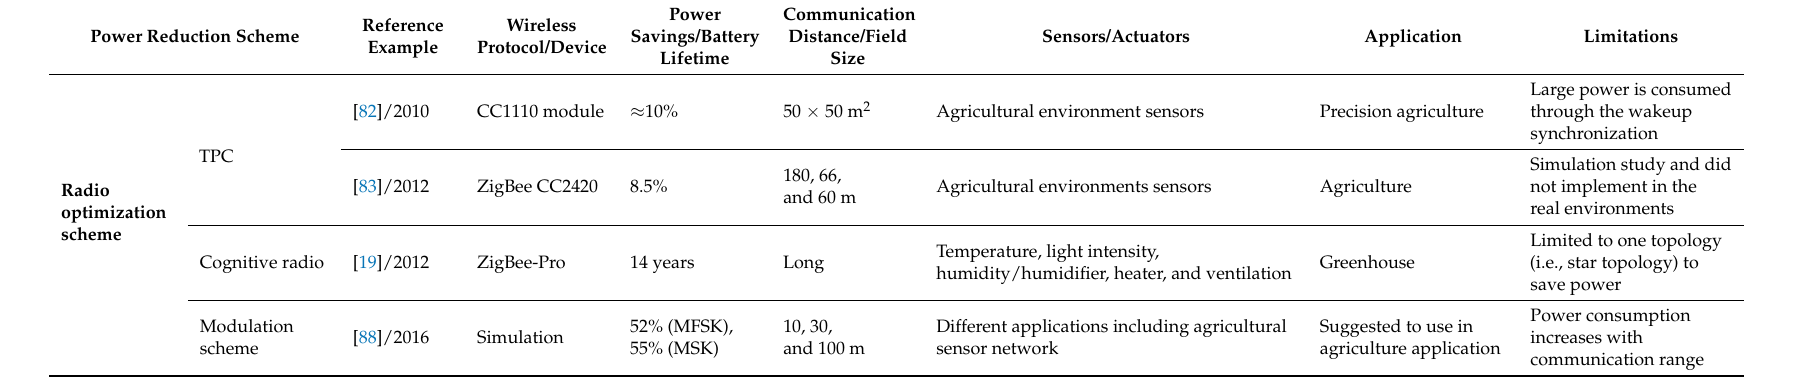
Table 3. Radio optimization schemes for previous research in agricultural